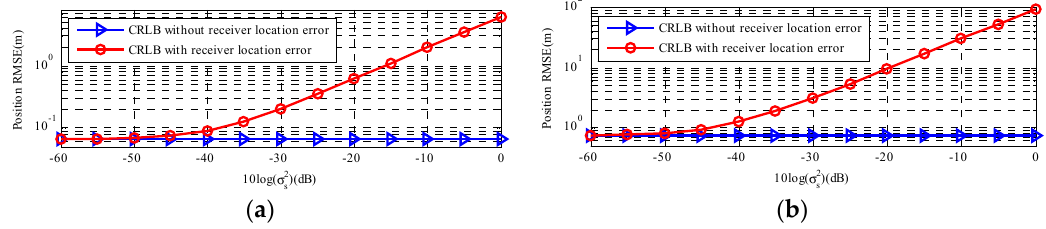
Figure 4. CRLB comparison versus sensor location error. ( a ) The near-field stationary source; ( b ) The